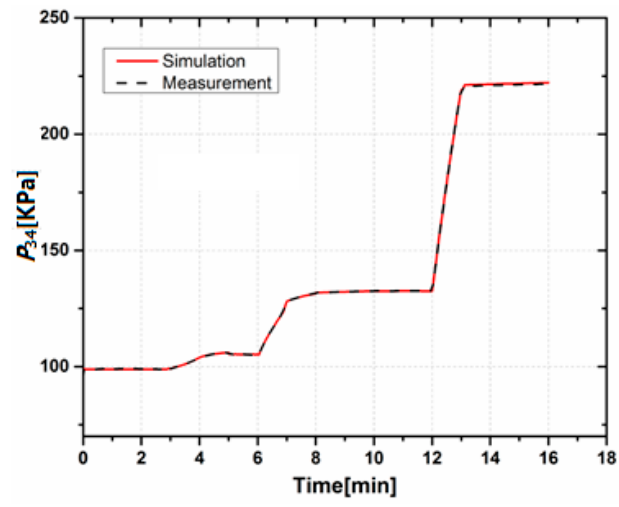
Figure 7. Comparison of simulation results and measuring data for high-pressure turbine discharge pressure.